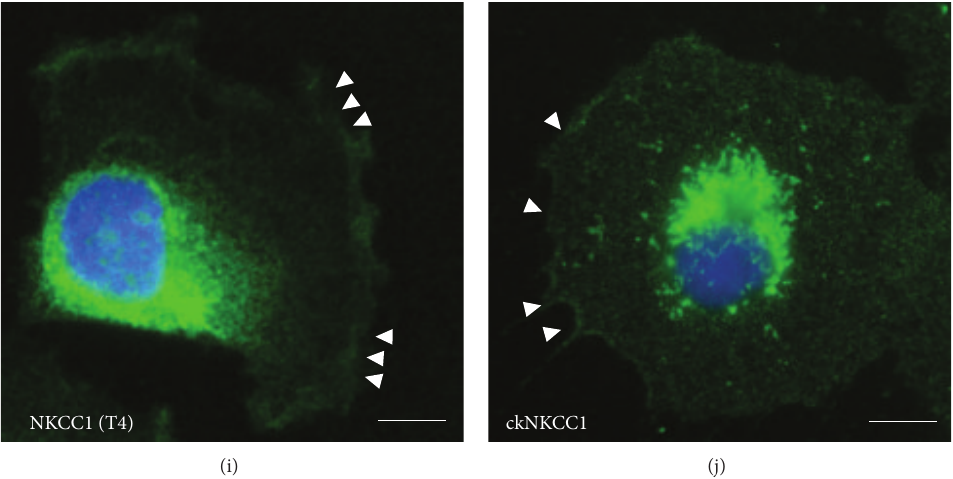
Figure 2: Validation of NKCC1 antibodies in COS7 cells. (a) Representative immunoblot of protein lysates obtained from COS7 cells and developed by using T4 or ckNKCC1. Shown is NKCC1 protein expression detected as two major bands, one of ∼ 130kDa and another of ∼ 170kDa. ((b)-(c)) Representative immunoblots of liver (b) or kidney (c) tissue extracts from WT or NKCC1 KO mice, developed by using T4 (b) or ckNKCC1 (c). Shown are bands of predicted MWs corresponding to NKCC1 only in WT tissues. (d) Representative immunoblots of COS7 shControl and COS7 shNKCC1 protein extracts developed by using T4. Shown are bands of predicted MWs corresponding to NKCC1 only in COS7 shControl cells. ((e)–(h)) Representative images of COS7 shNKCC1 cells stably expressing shRNAs against NKCC1 and GFP as a reporter (e) immunolabeled by using T4 coupled to Cy3-conjugated secondary antibodies (f). Cell nuclei were counterstained with DAPI (g) and the pictures superimposed (h). ((i)-(j)) Immunofluorescence of COS7 cells using T4 (i) or ckNKCC1 (j) coupled to FITC-conjugated secondary antibodies. Arrowheads indicate NKCC1-immunoreactivity at/near the edge of cells. Pictures in (e)–(h) and (i)-(j) were taken at 400x and 600x, respectively. Bar represents 10 𝜇